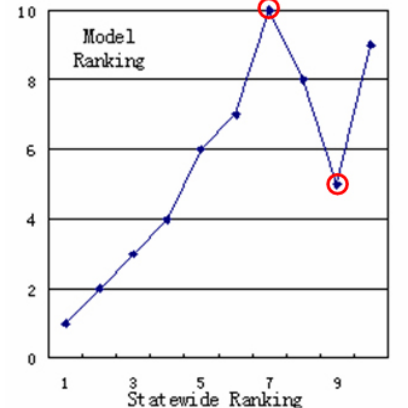
Fig.5. Model Evaluation for Type-342 Intersection